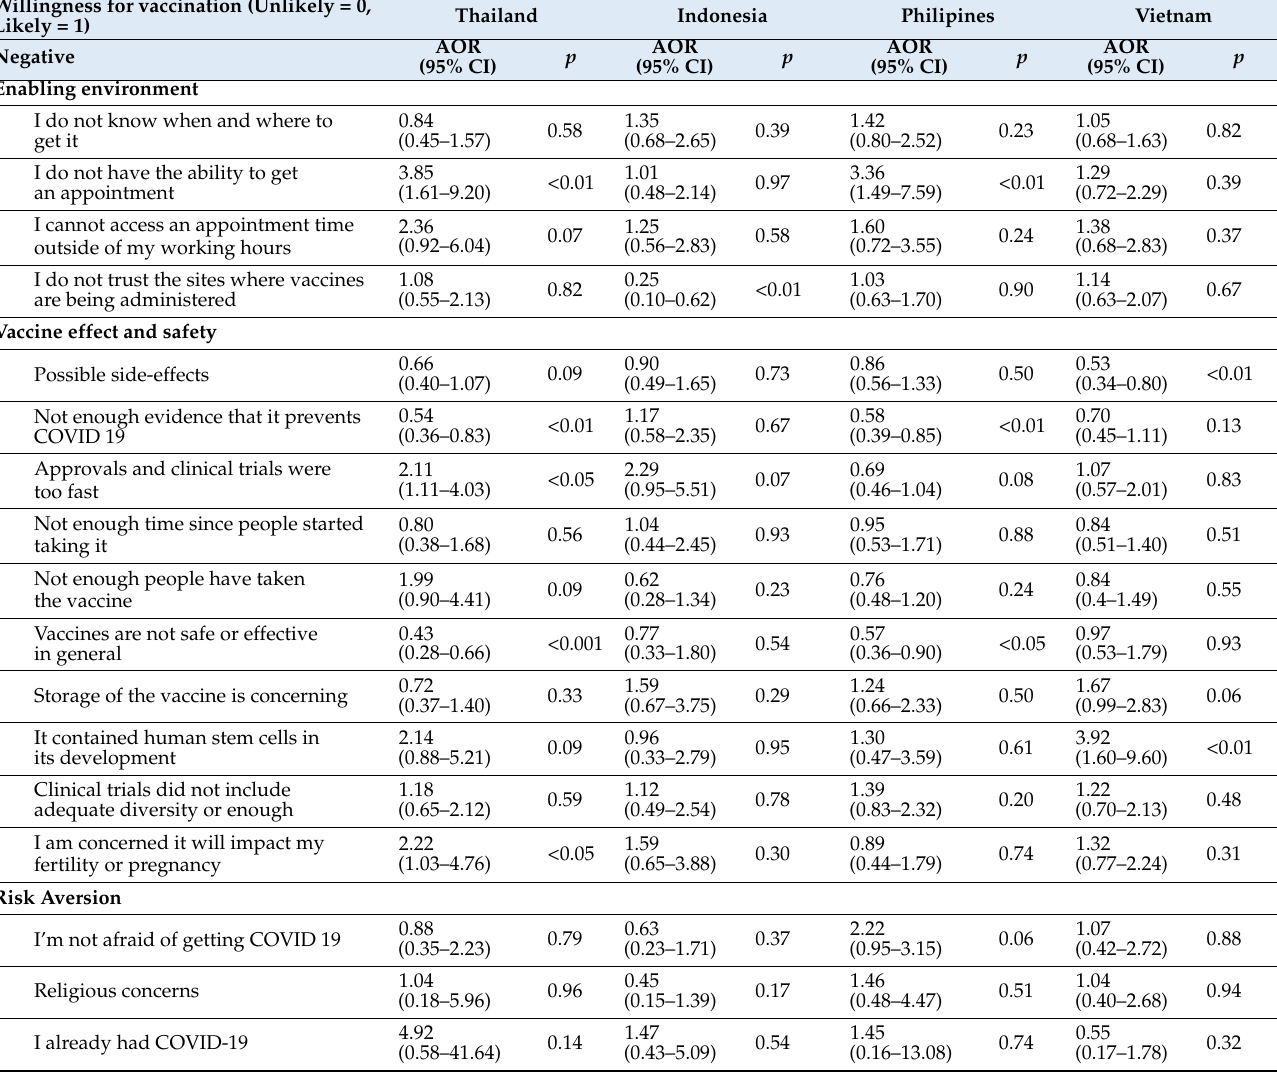
Table 11. Binomial logistic regression of willingness for vaccine with negative reasons (factor) to